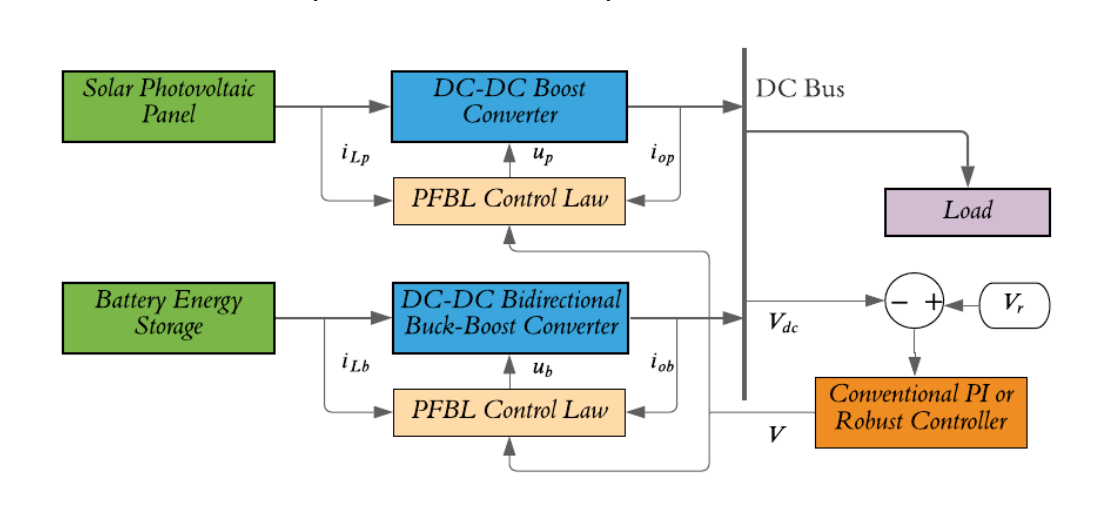
Figure 5. Implementation block diagram of proposed partial feedback linearized control scheme with conventional PI and robust H ∞